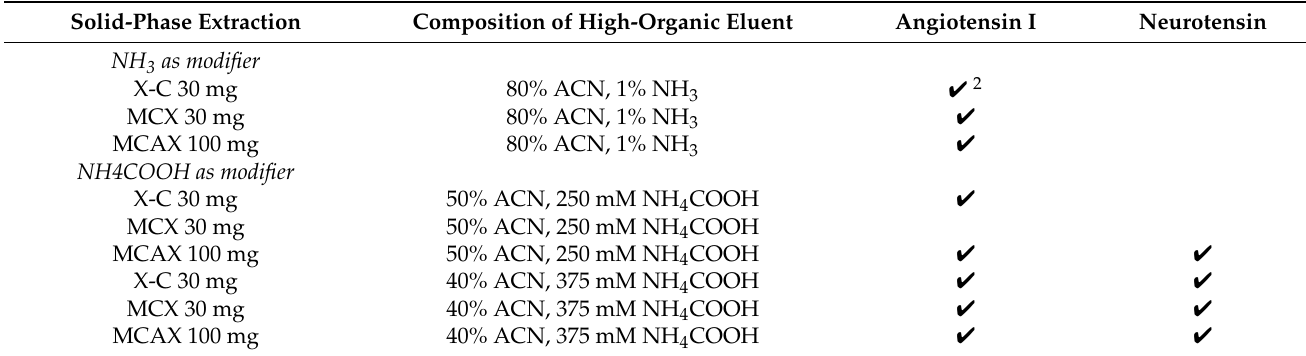
Table 2. Detection of peptide standards in high-organic fraction collected from mixed-mode solid- phase extraction 1 eluted by eluents modified by ammonia or ammonium